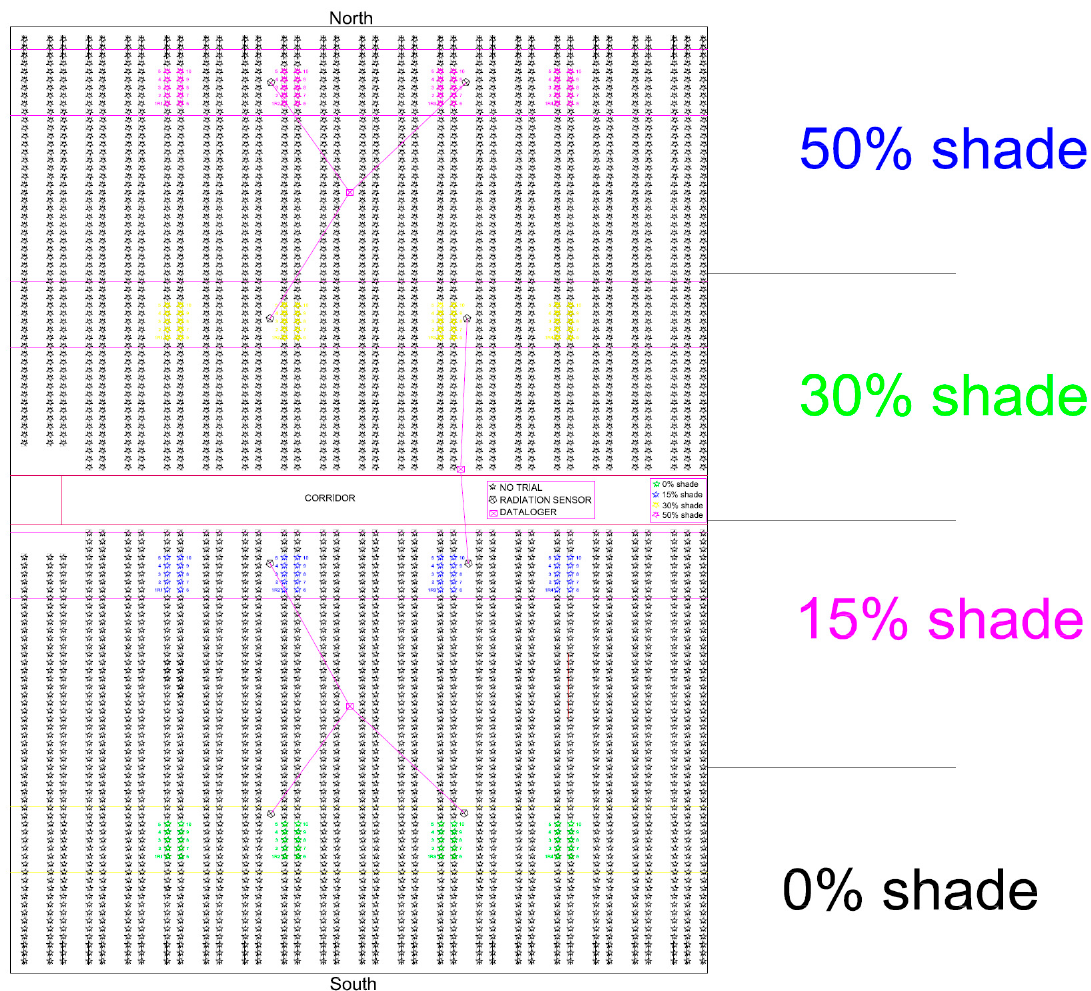
Figure 5. Plants distribution by repetition and treatment inside the greenhouse. Location of the radiation sensors.